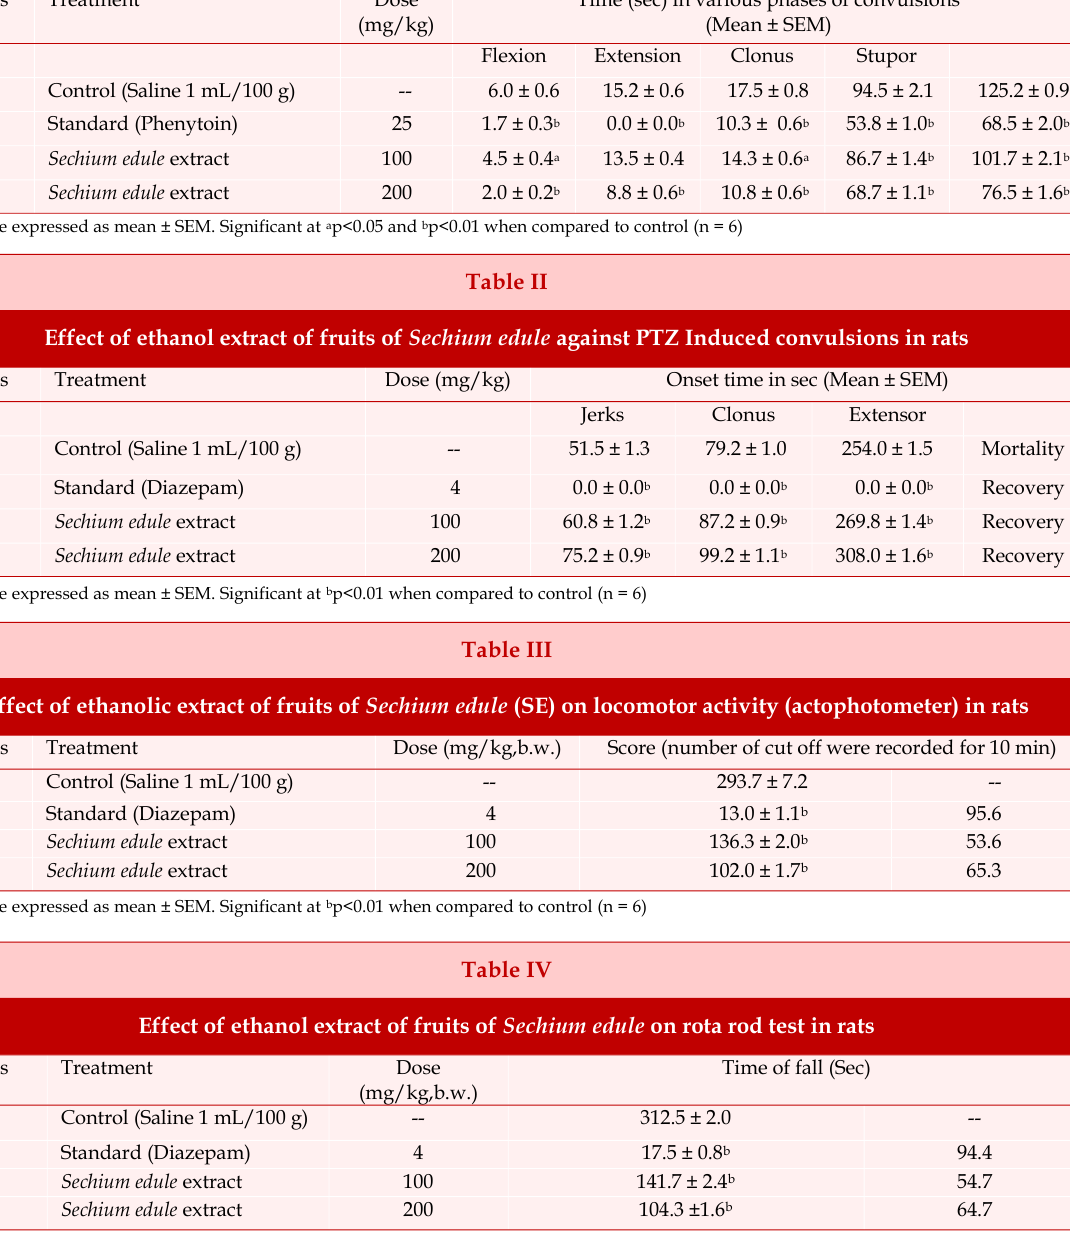
Effect of ethanol extract of fruits of Sechium edule against MES Induced convulsions rats Groups